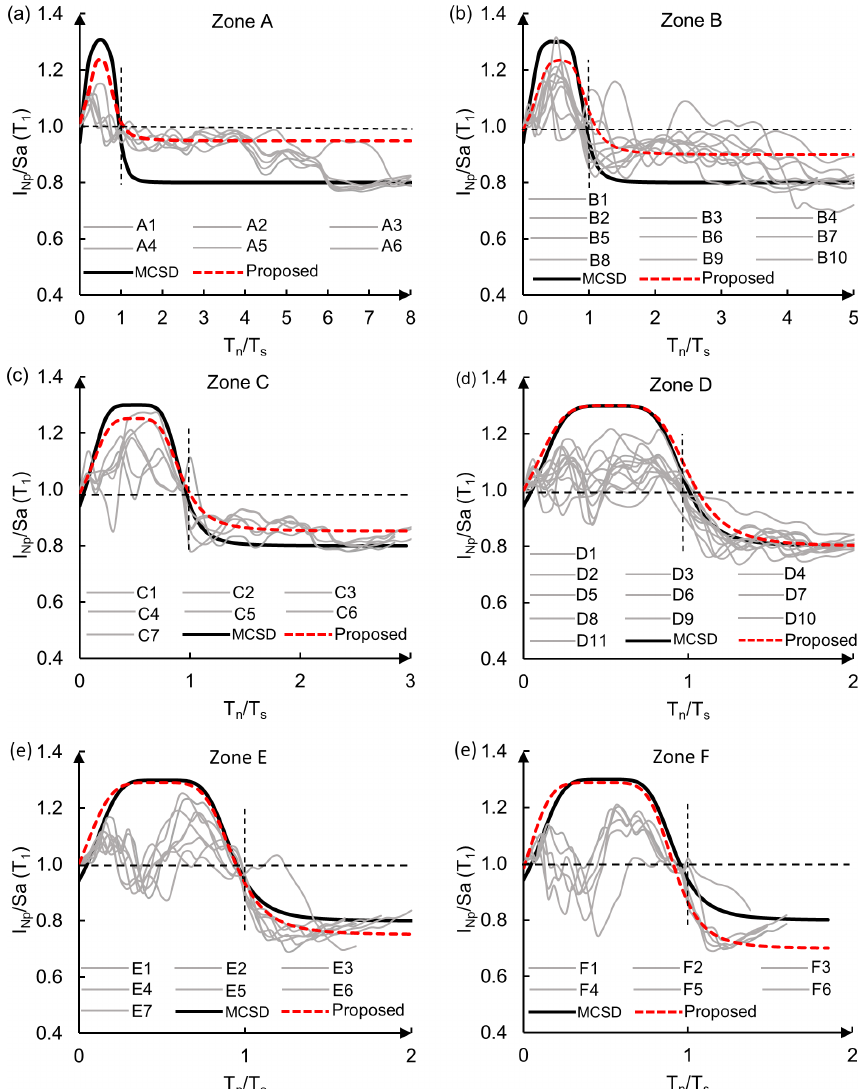
/ Sa (T 1 ) ), for the recording stations, corresponding to and Sa( T 1 ) ( I N p p